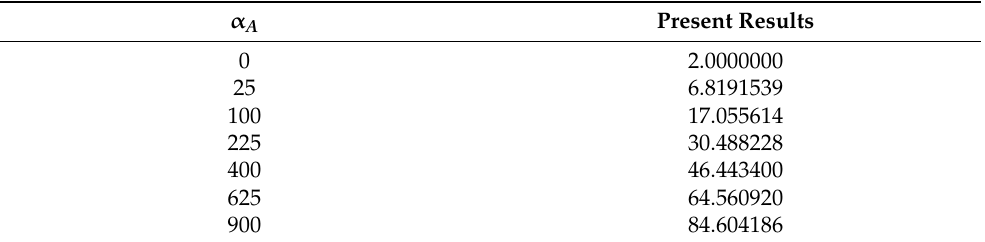
Table 2. A judgment of F (cid:48)(cid:48) ( 0 ) with Lok et al. [34] for dissimilar selected values of α A when φ a = φ λ = b = f s = 0 and